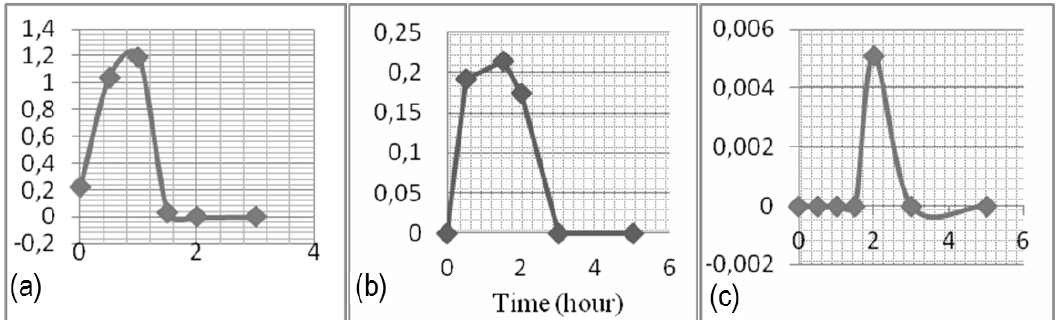
Figure 4. Linearity of andrographolide against detector response in rabbit plasma (a), stomach (b), and liver (c)